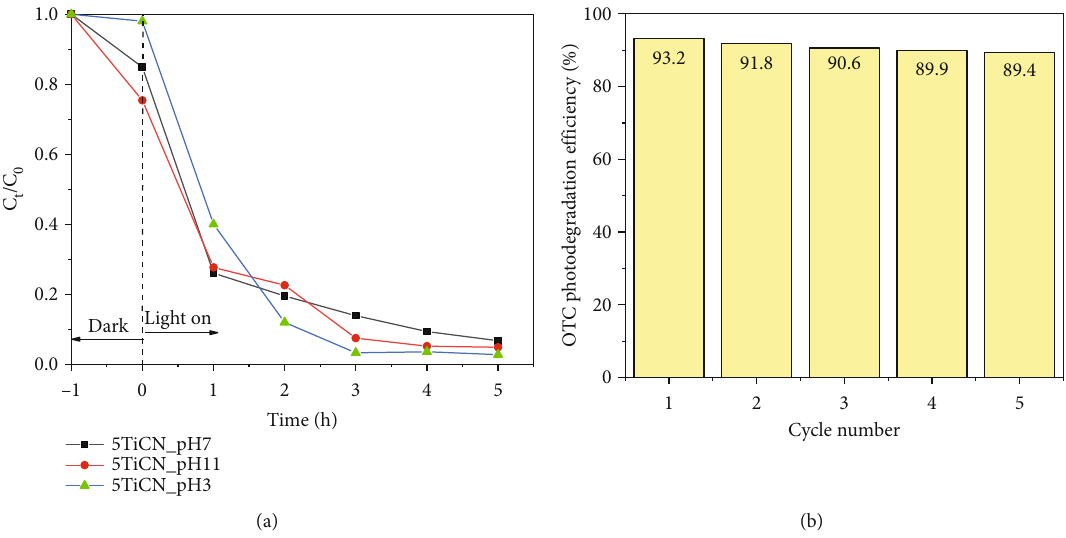
Figure 8: Photodegradation e ffi ciency of OTC in function of pH (a) and photostability test on 5TiCN (b).